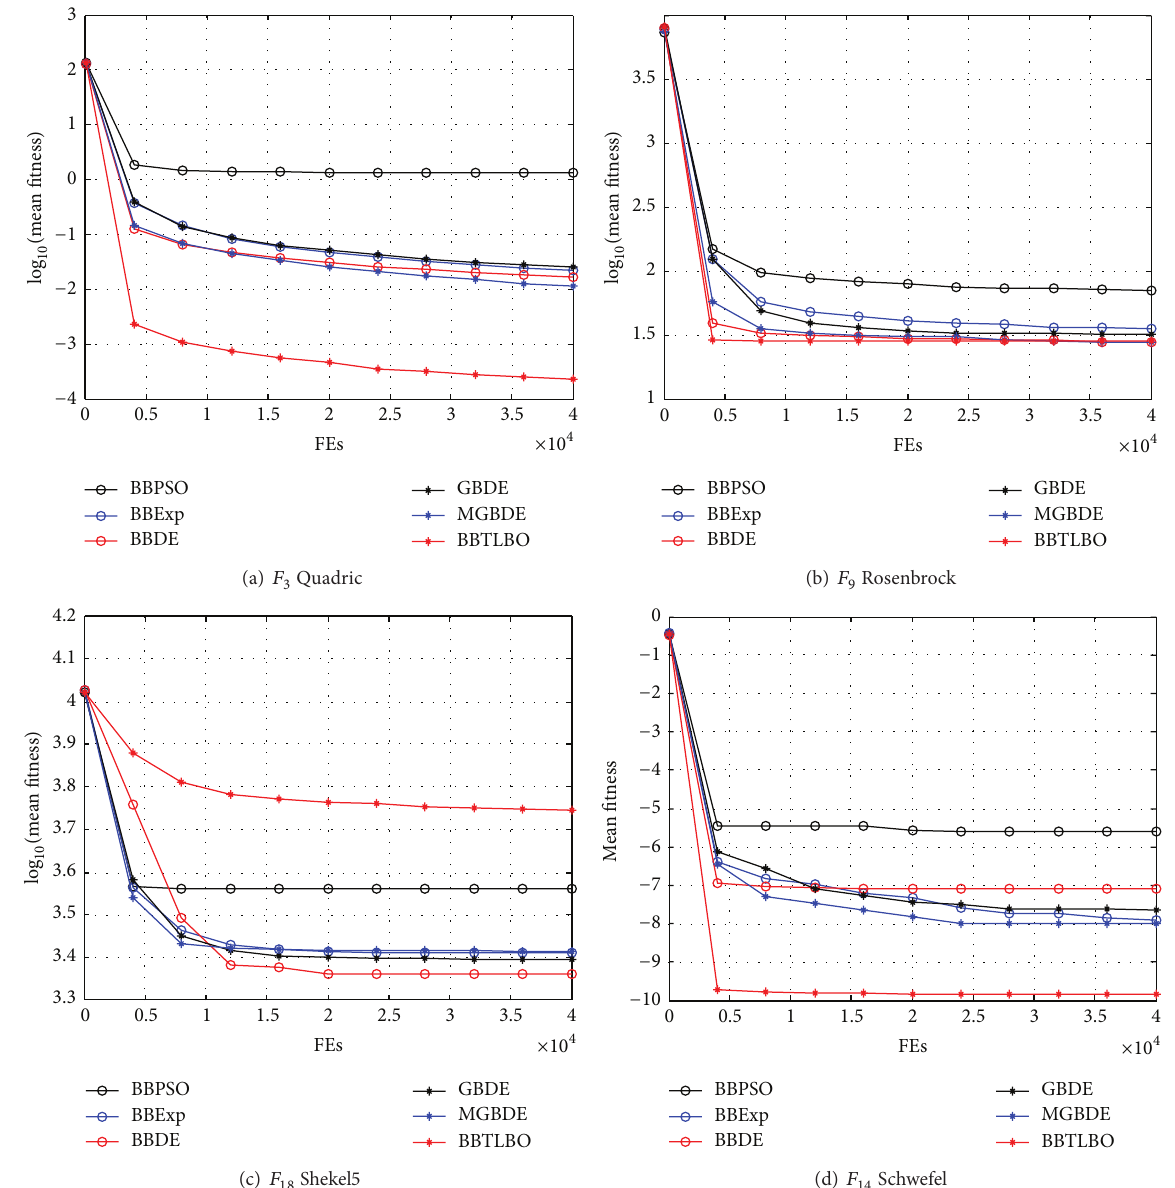
Figure 4: Comparison of the performance curves using different algorithms.